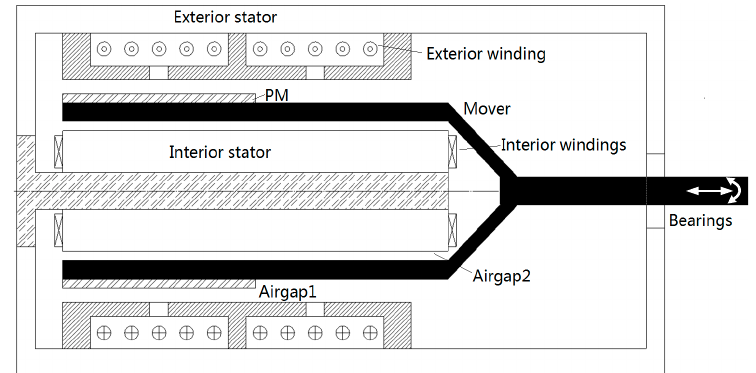
Figure 1. Section view of the mechanical structure.